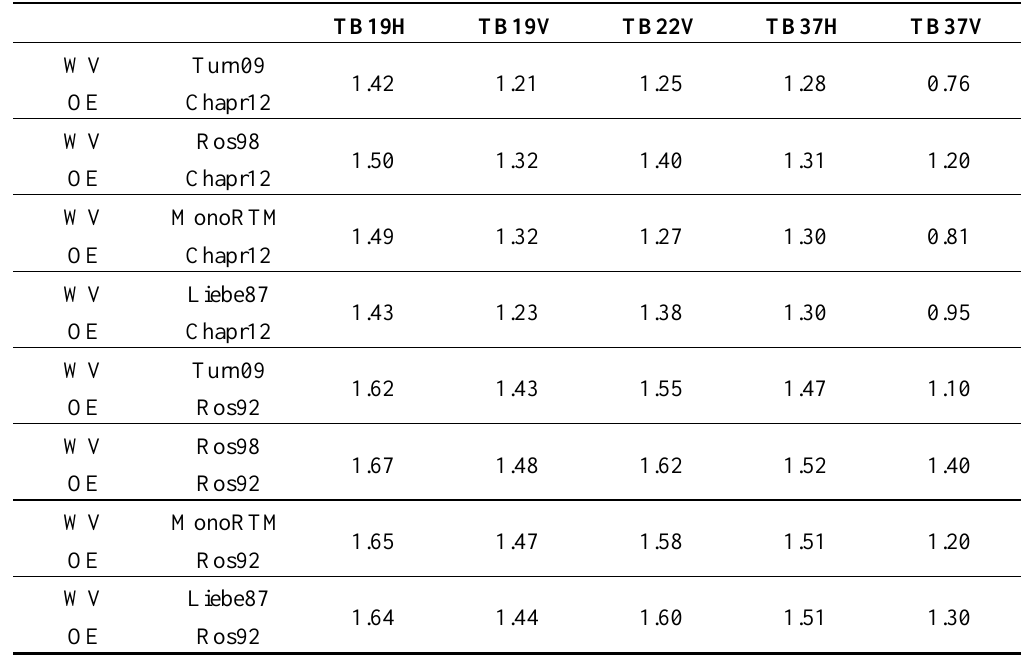
Table 2. Root mean square difference (in K) between simulations and measurements for eight model combinations for SSMIS lower frequency channels. Liebe87 is used for oxygen absorption. TB19H TB19V TB22V TB37H TB37V WV Turn09